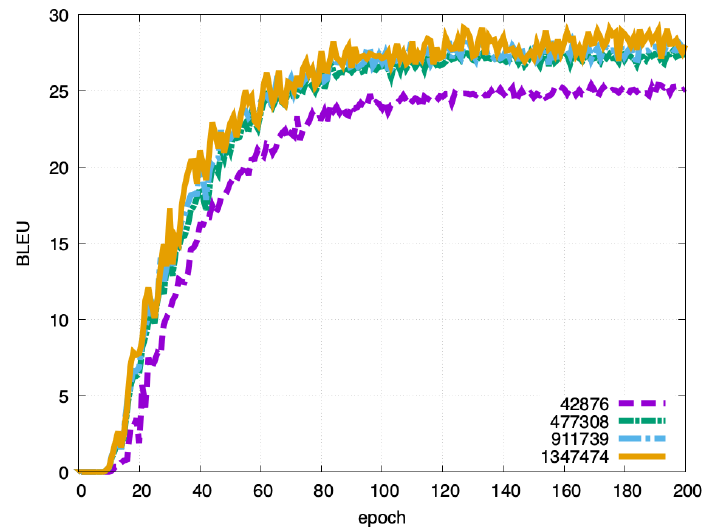
Figure 10. Effect of data size changes for English–Japanese translation. As in Figure 7, the results up to epoch 200 are shown.